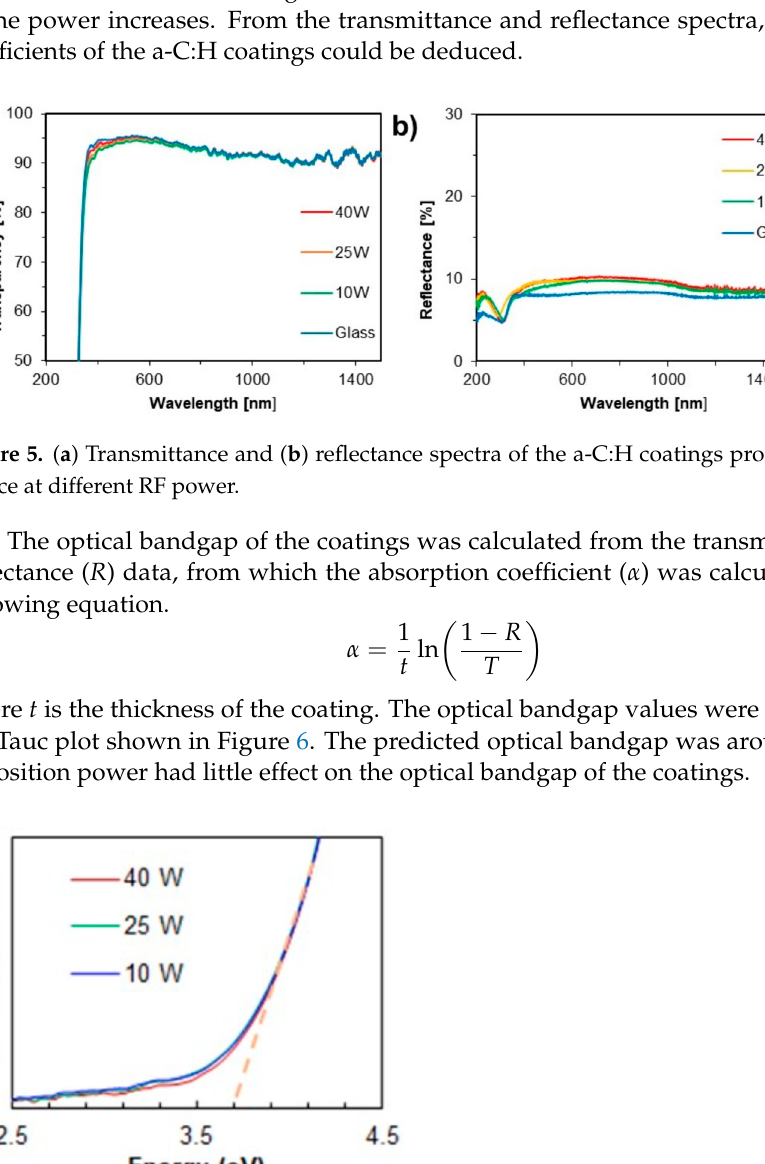
Figure 4. AFM images of a-C:H coatings on Si substrate with deposition power of ( a ) 10 W, ( b ) 25 W, and ( c ) 40 W.